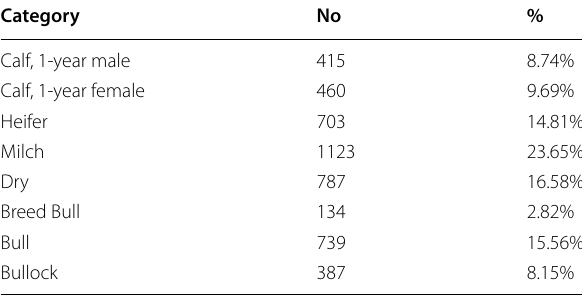
Table 1 Yak category composition Category